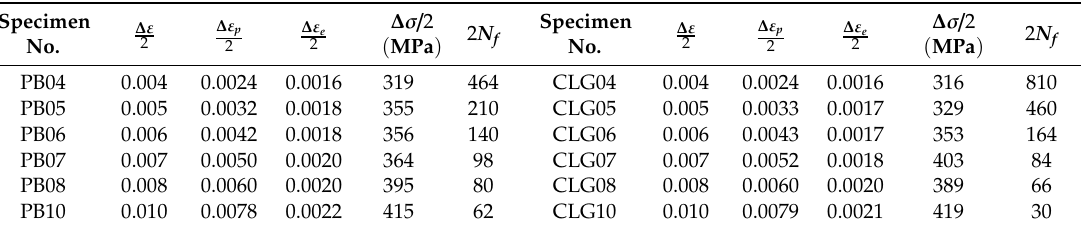
Table 2. Strain amplitude used in the tests and test results.